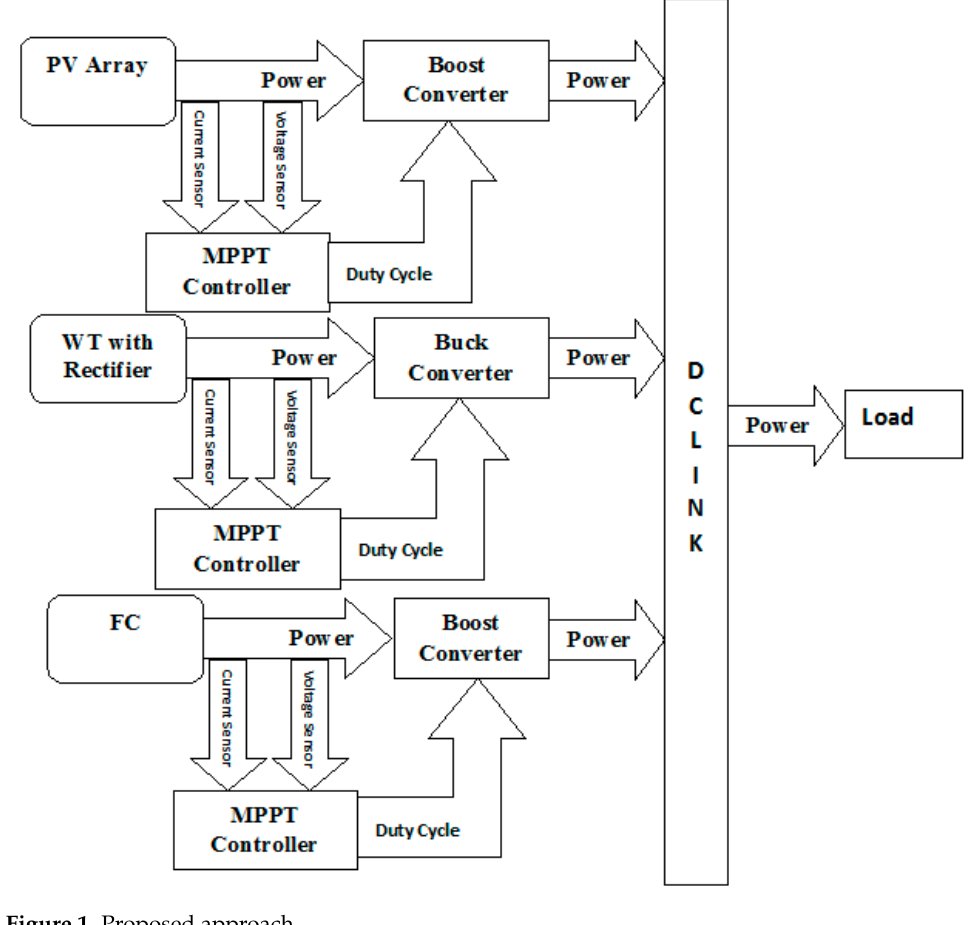
Figure 1. Proposed Figure 1. Proposed approach.